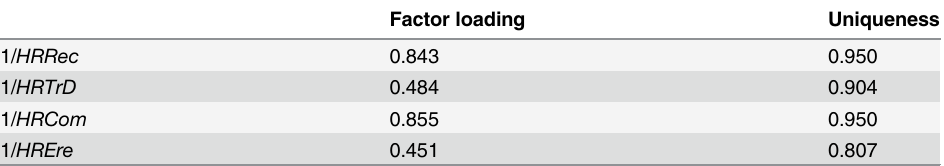
Table 4. Factorial analysis of OvHR.